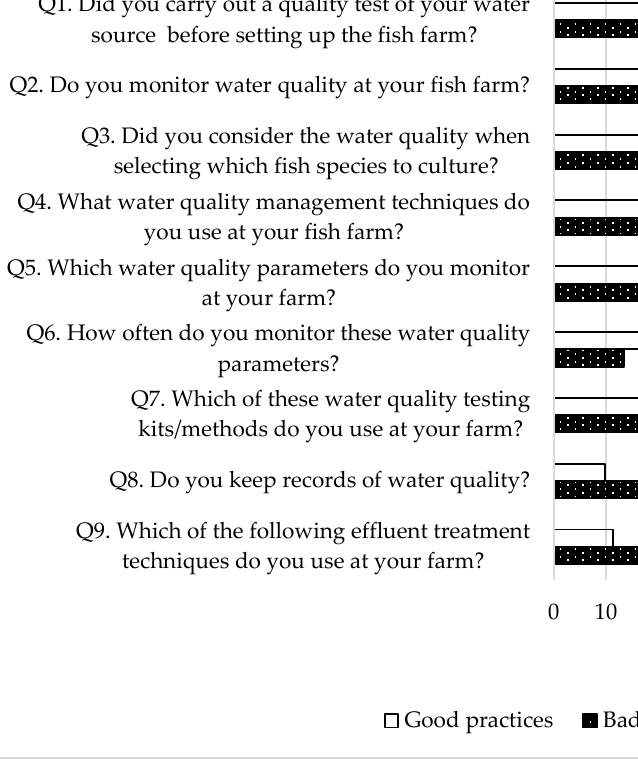
Figure 4. Percentage frequencies of correct (good practices) and incorrect (bad practices) responses to questions about practices regarding water quality and its management among fish farmers of the Rwenzori region.